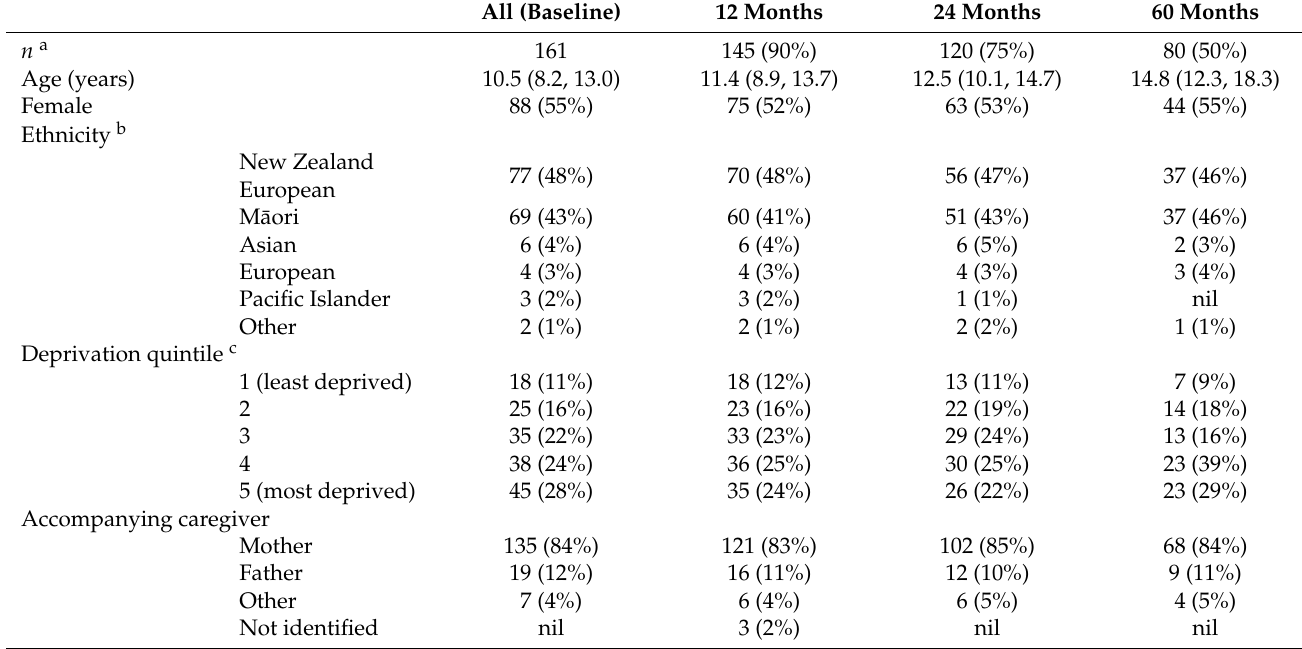
Table 1. Demographic characteristics of Wh¯anau Pakari participants included in analyses of health knowledge over time (food knowledge